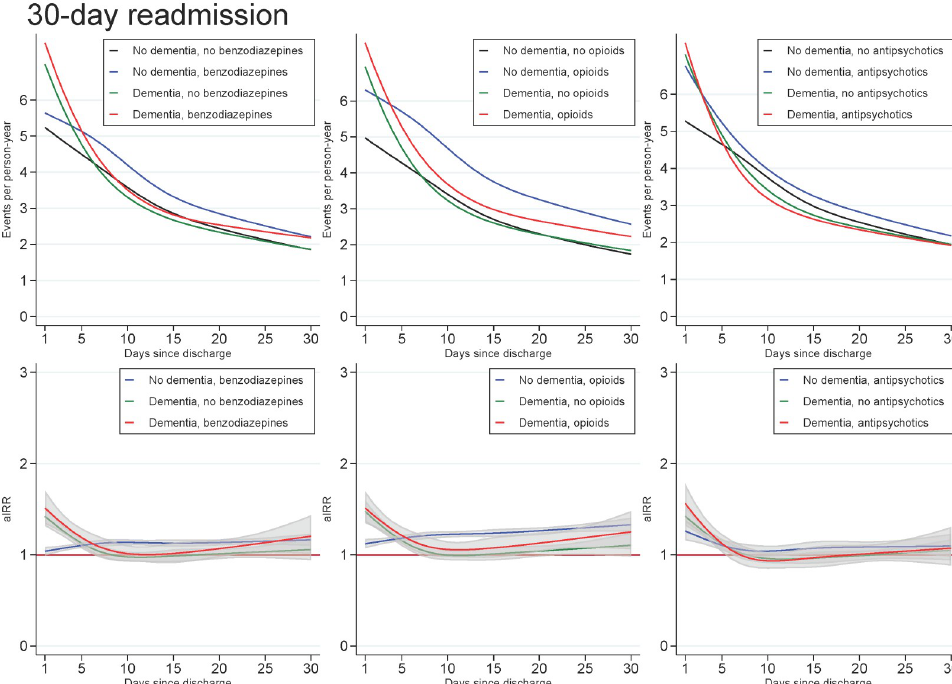
Fig 4. Unadjusted readmission rates and adjusted incidence (readmission) rate ratios for patients with dementia (without medication use), patients with use of benzodiazepines, opioids or antipsychotics (without dementia), and patients with both or neither exposures, plotted as a function of days since discharge. Abbreviations: aIRR: adjusted incidence (readmission) rate ratios. IRRs adjusted for sex, age, calendar period, cohabitation status, length of stay, type of pneumonia diagnosis, time since discharge, somatic comorbidities, psychiatric comorbidities, and alcohol/substance abuse.